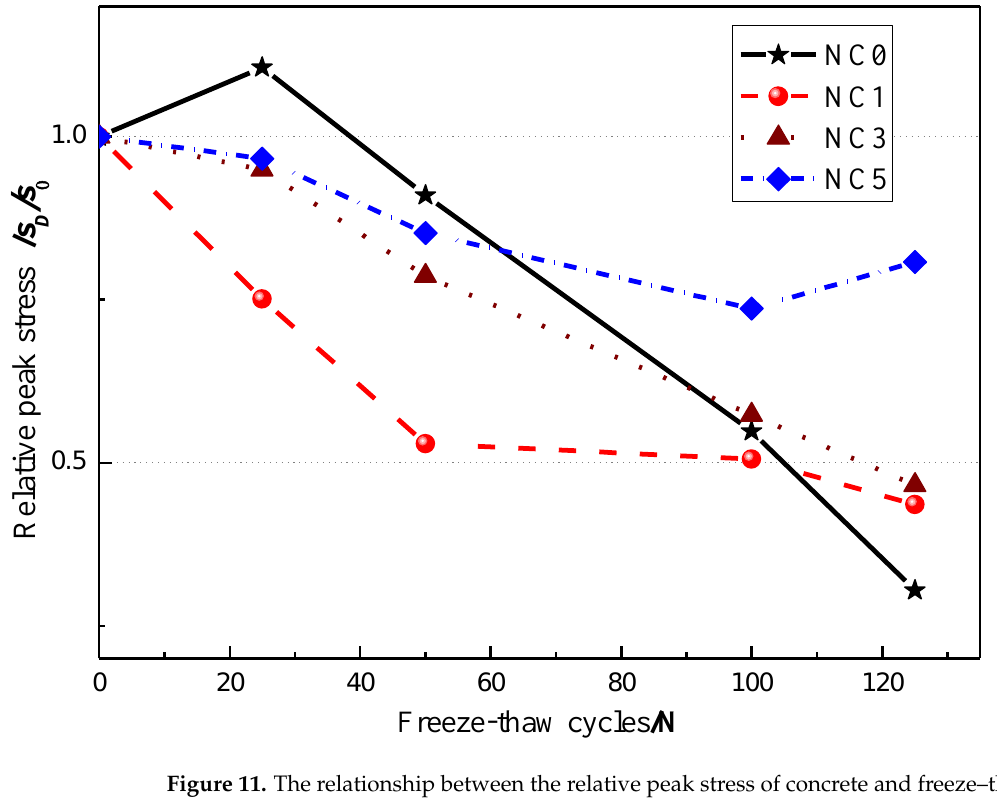
Figure 11. The relationship between the relative peak stress of concrete and freeze – thaw cycles. The relationship between the relative peak strain of NMK concrete and the number of freeze-thaw cycles is shown in Figure 12. It can be seen from the diagram that the rel- ative peak strain of concrete increases with the increase of freeze-thaw cycles, indicating that the ability of concrete to resist deformation under axial pressure gradually decreases with the increase to internal damage of concrete.